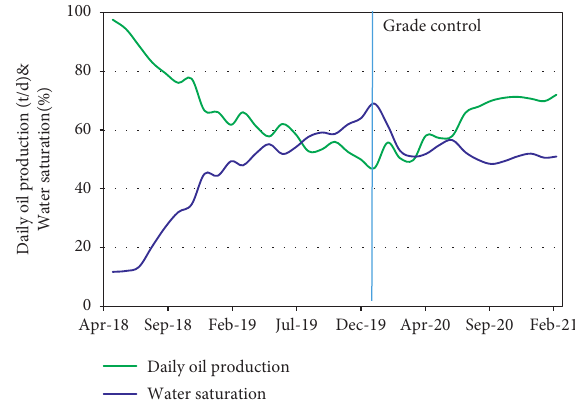
Figure 15: Production performance of wells in the pilot test